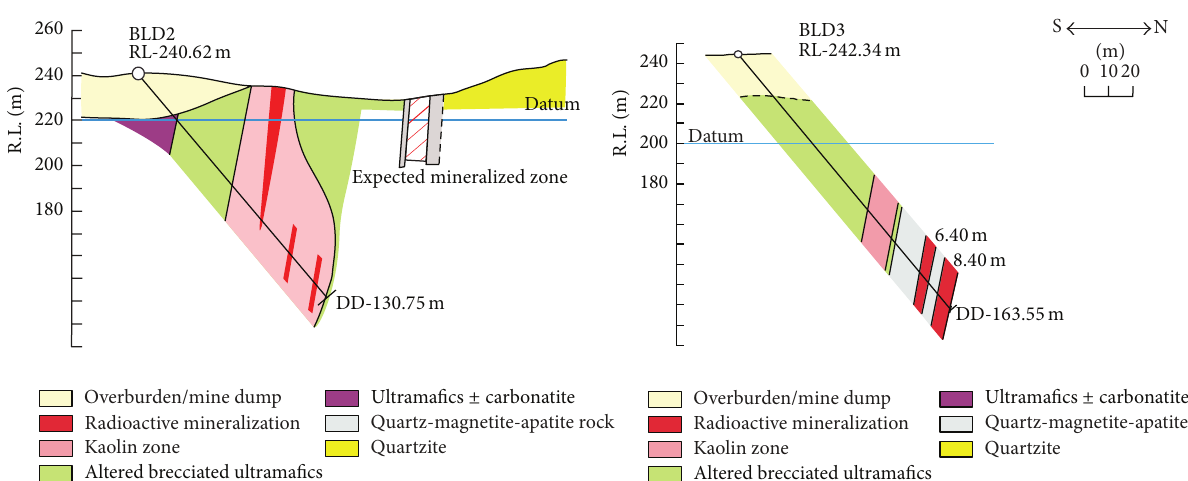
Figure 11: Transverse sections through bore holes BLD2 and BLD3 (after [7]).